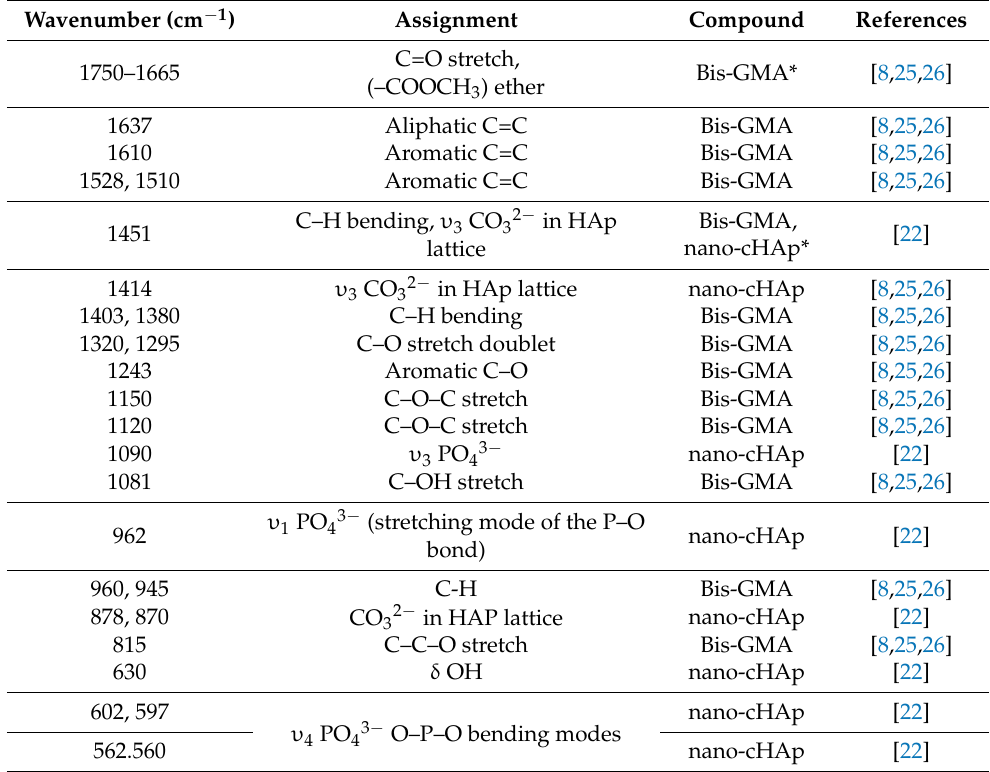
Table 2. Molecular vibrations in the FTIR spectra of biomimetic